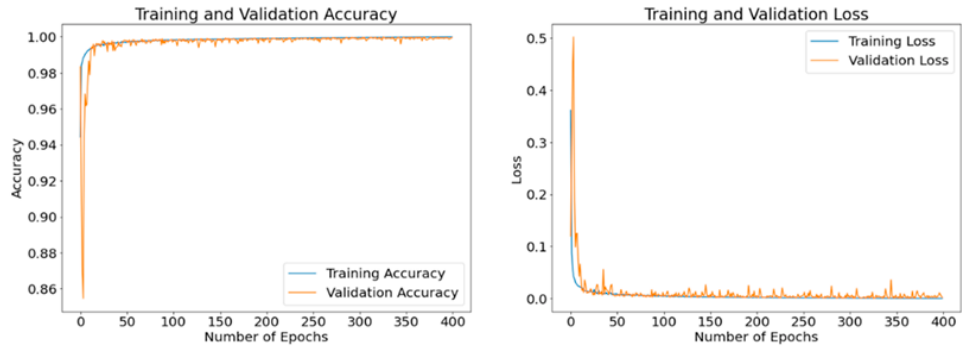
Figure 16. Accuracy and loss curves generated by RMSProp optimizer after model training (blue) and validation (orange) using a batch size of 16 samples and up to 400 epochs.